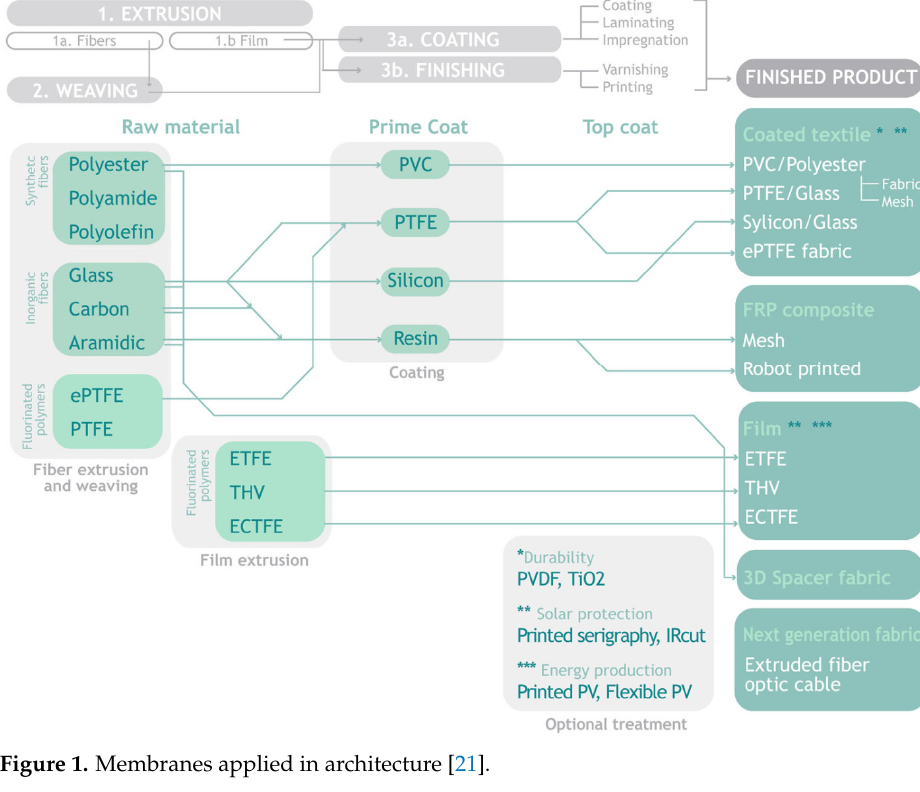
Figure 1. Membranes applied in architecture [21].